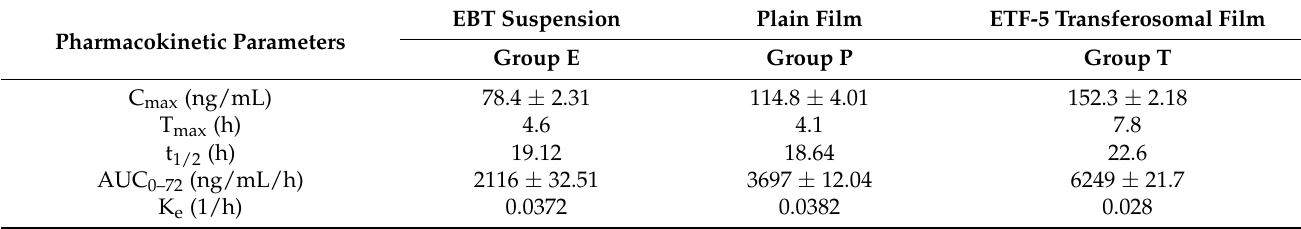
Figure 10. Mean plasma concentration-time profile for carebastine following oral treatment of EBT suspension, EBT plain film and ETF5.